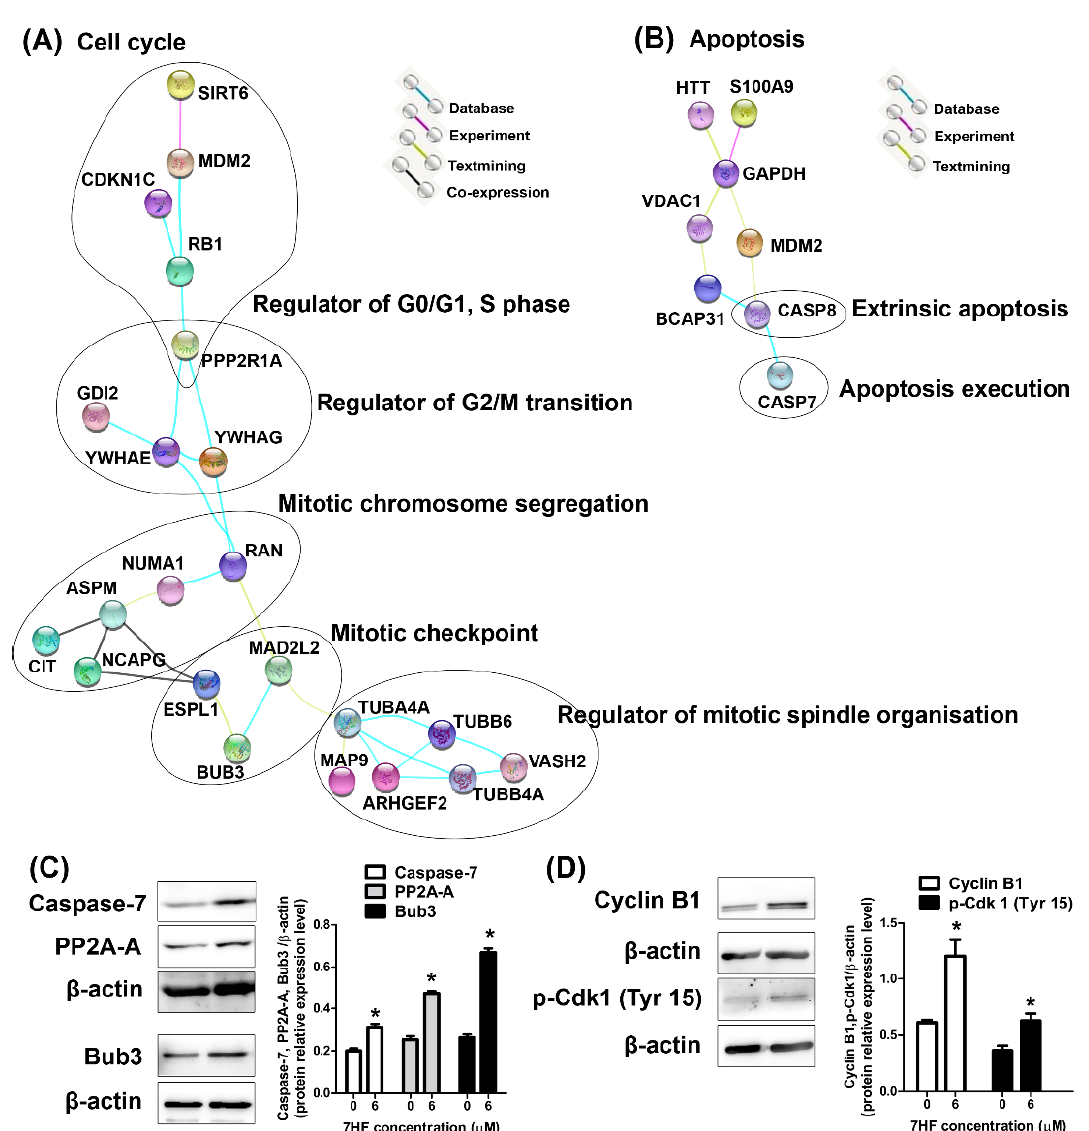
Figure 4. Protein–protein interactions, validated proteins and G2/M-phase-controlled proteins in triple-negative breast cancer cells treated with 6 µ M 7- α -hydroxyfrullanolide (7HF) for 24 h. Construction of the ( A ) integrated cell cycle and ( B ) apoptosis signaling networks, respectively. The black drawing indicates the known protein functions. The abbreviations used in STRING represent the protein names shown in Table 2. ( C ) Protein expression was validated using proteomics. ( D ) Cyclin B1 and phosphorylated Cdk1 (p-Cdk1) (Tyr 15) expression after 7HF treatment. Data represent mean ± SD values from three independent experiments. The significance of mean differences was analyzed using one-way ANOVA with Tukey’s HSD multiple comparisons. * p < 0.05, compared to the control.